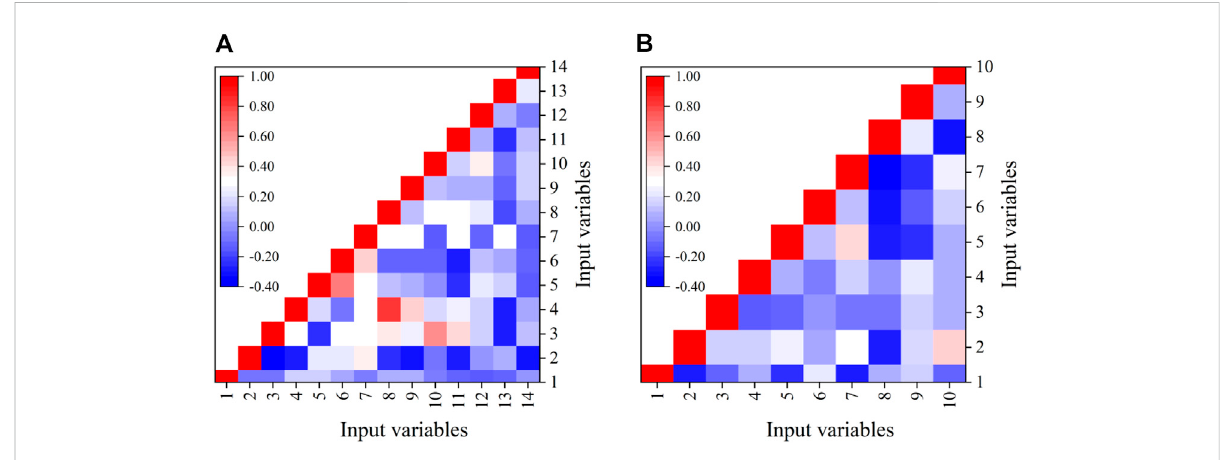
FIGURE 2 Independence among 14 variables (A) and 10 reconstructed variables (B)